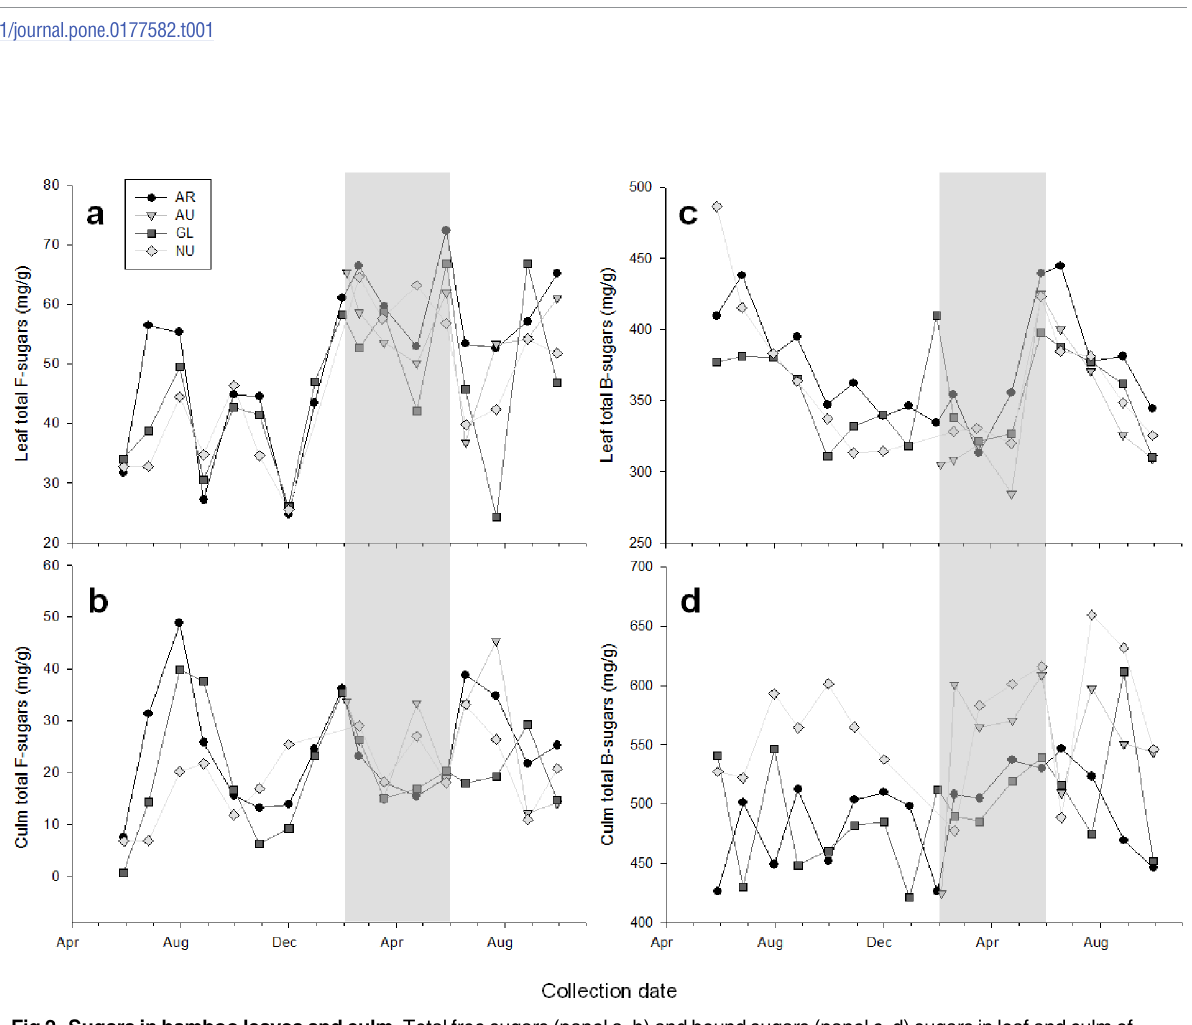
Data are shown as mean ± SEM, with the range shown in brackets for the entire 18–27 sampling period. Data are expressed as percentage of dry matter (DM).